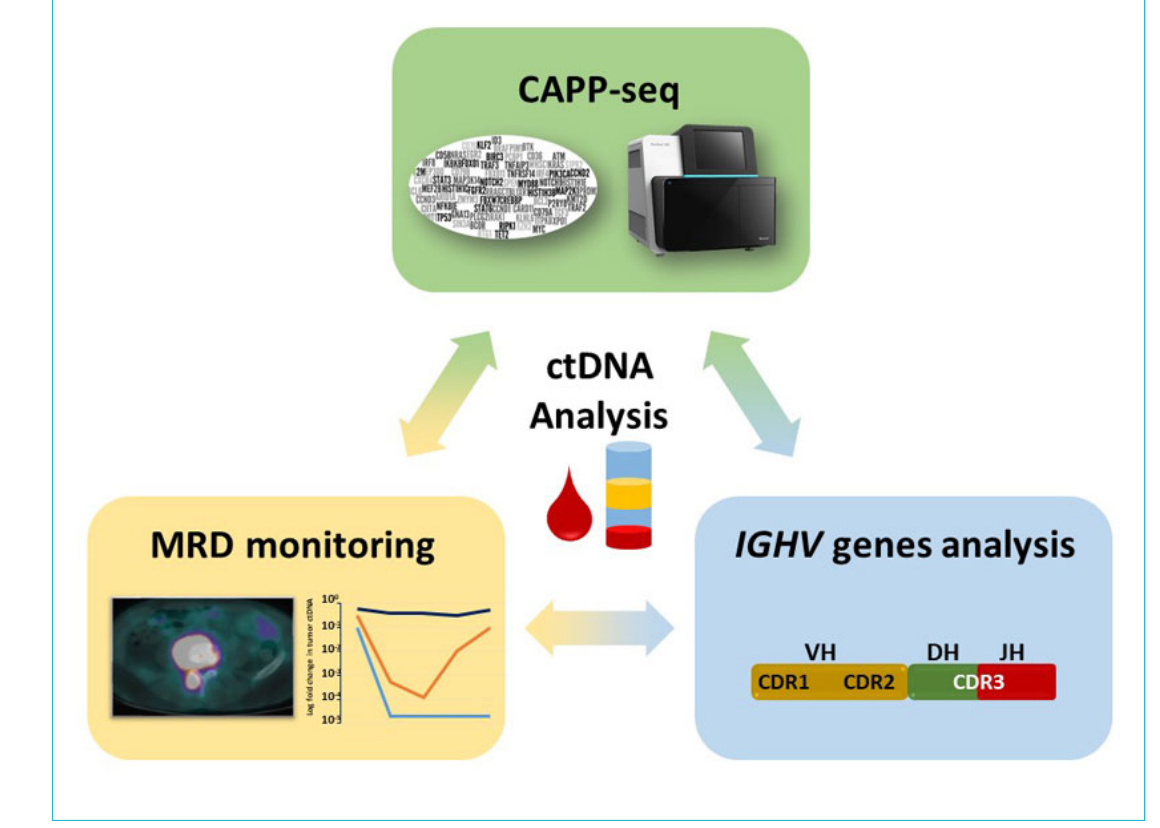
Figure 1: Molecular applications of plasma circulating tumour DNA